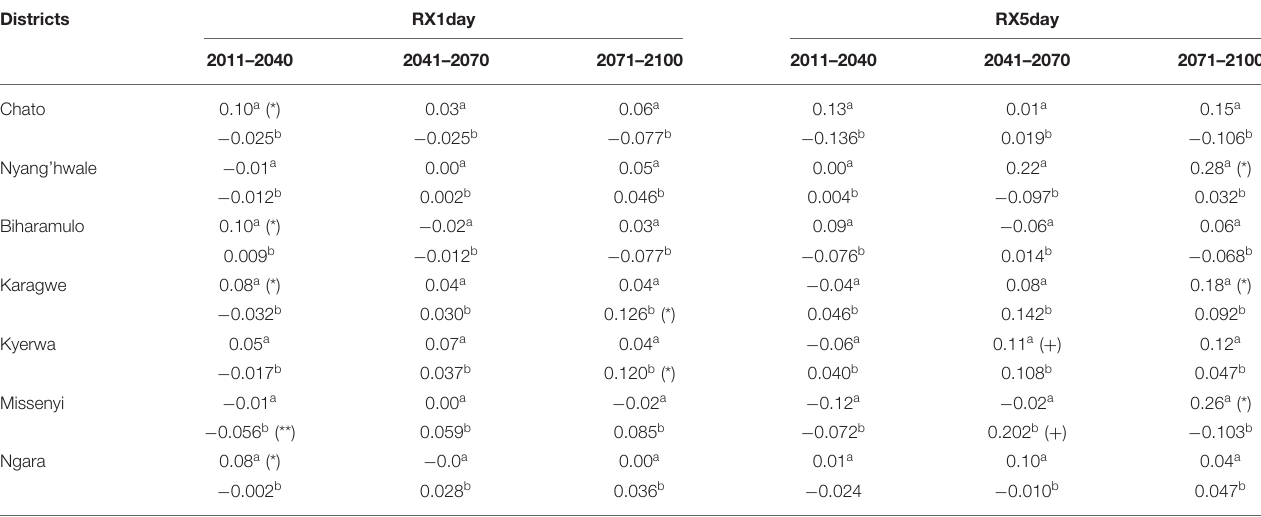
TABLE 10 | Projected extreme climate indices related to intensity in the Kagera and Geita regions during the present (2011–2040), mid (2041–2070) and end. (2071–2100) centuries under Representative Concentration Pathway a (RCP) 4.5 scenario and b RCP 8.5 scenario.